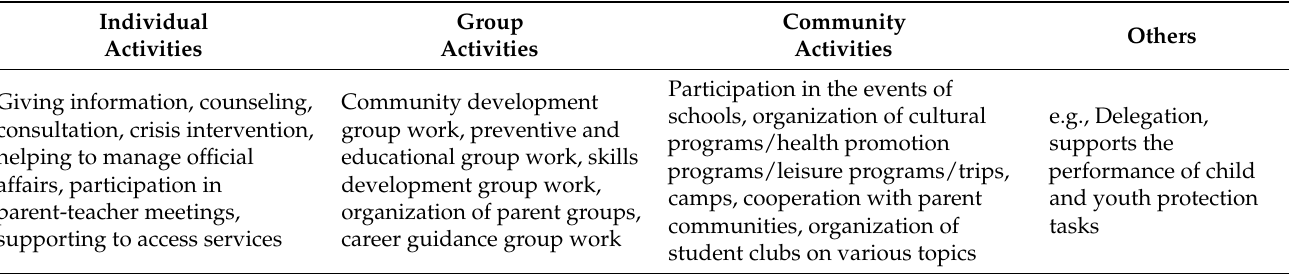
Table 2. Areas of tasks for school social workers in